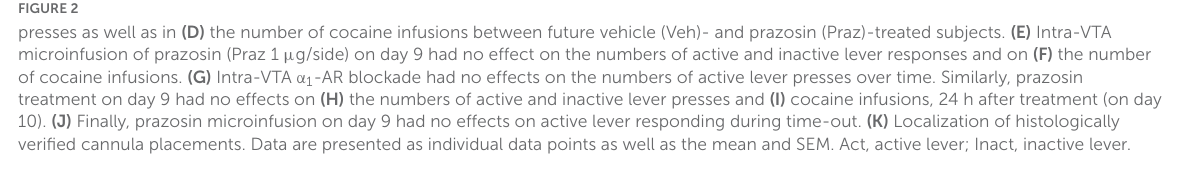
microinfusion, rats were placed in the center of an open field apparatus (black Plexiglas 80 × 80-cm arena with 60-cm-high black Plexiglas walls illuminated with a light intensity of 20 lux) and left inside for 30 min. Locomotor activity was tracked by a video camera and analyzed using ANY-maze software (Stoelting Europe, Dublin, Ireland). The apparatus was cleaned using 70% ethanol and dried after each